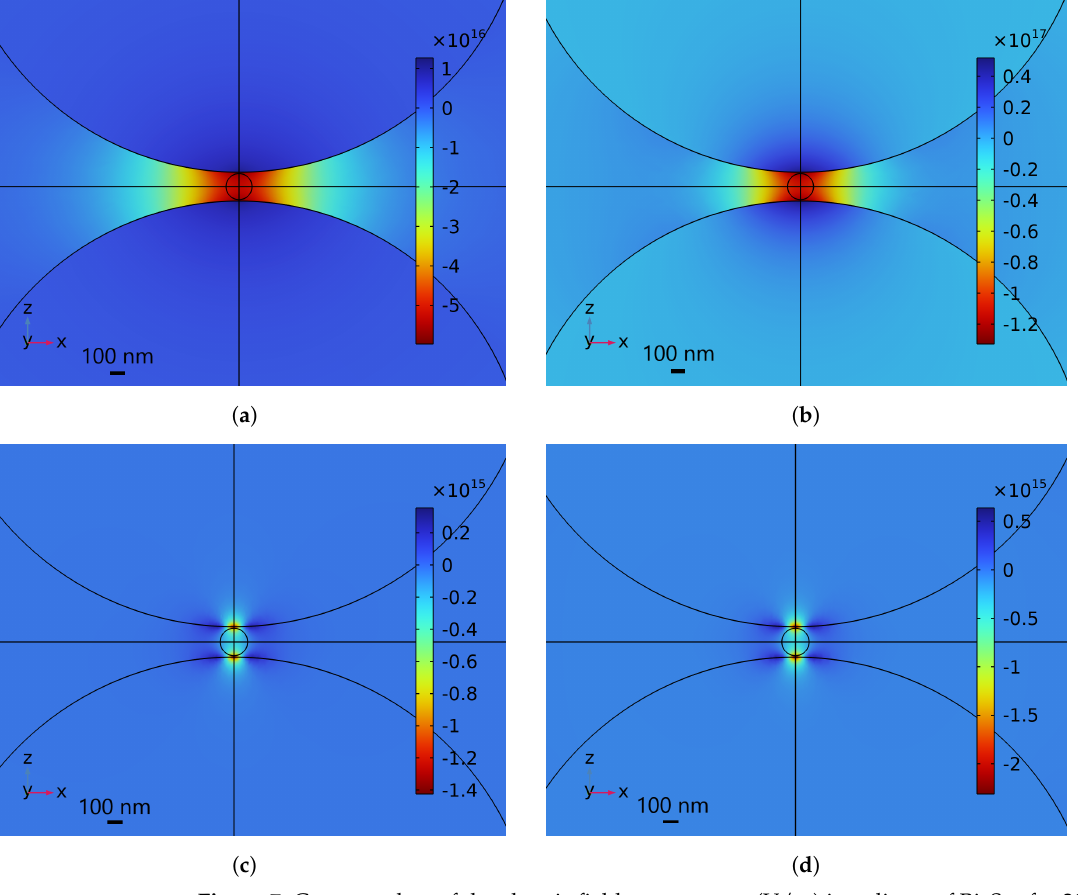
Figure 7. Contour plots of the electric field components (V/m) in a dimer of Bi 2 Se 3 for 200 nm gap. ( a ) E z at 9.4 THz (vertical dipole), ( b ) E z at 13.7 THz (vertical dipole), ( c ) E x at 9.4 THz (tangential dipole), ( d ) E x at 13.7 THz (tangential